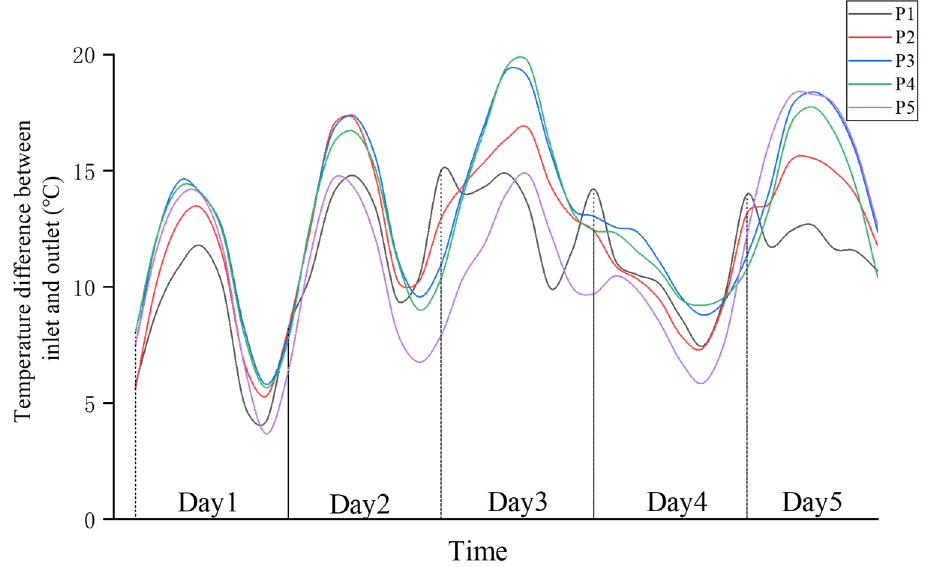
Figure 14. The temperature difference between inlet and outlet in winter.